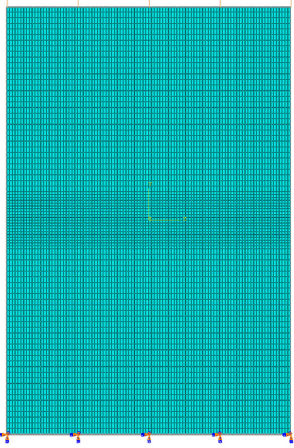
Figure 3. Mesh and elements.